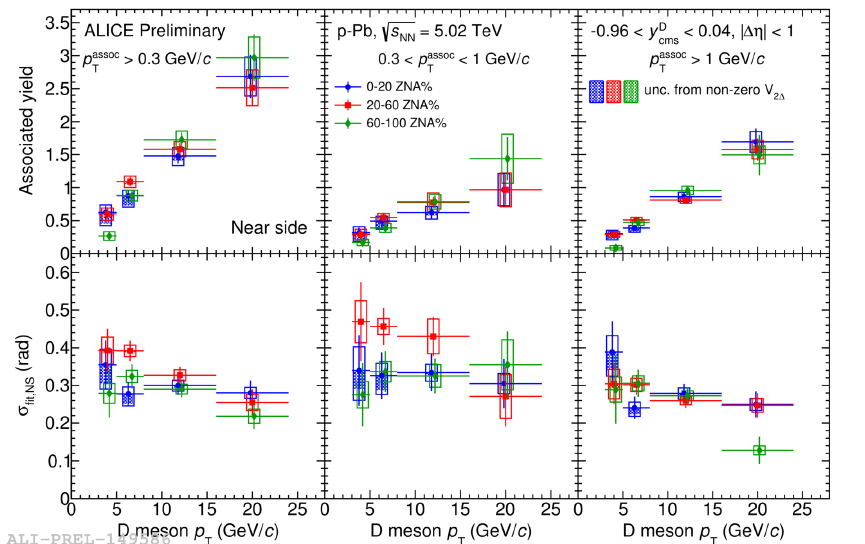
Figure 1. Comparison of near-side yield and width ( σ fit,NS ) in the different centrality classes. Each color is a different centrality class, as described in the legend. The error bars represent the statistical uncertainty, the empty boxes represent the overall systematic uncertainties, the shaded boxes represent the v 2 related